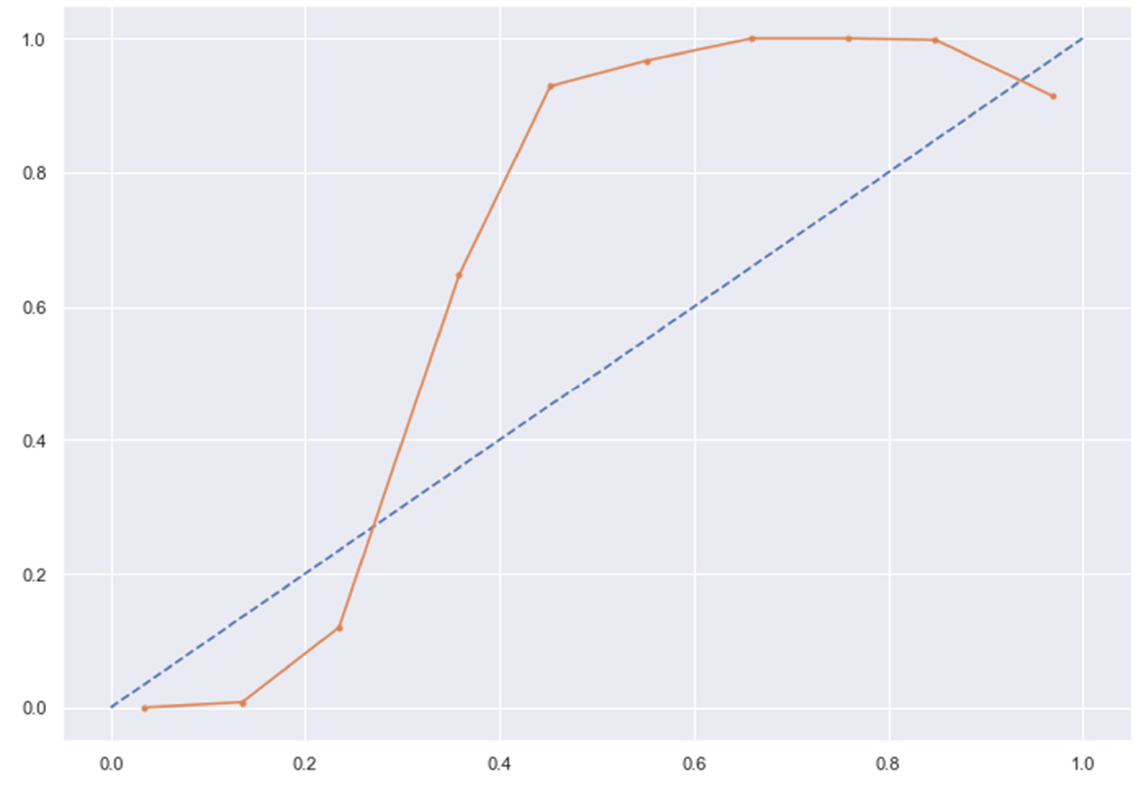
Figure 14. LR line without calibration vs. after calibration (Ideal fit is represented as blue line).